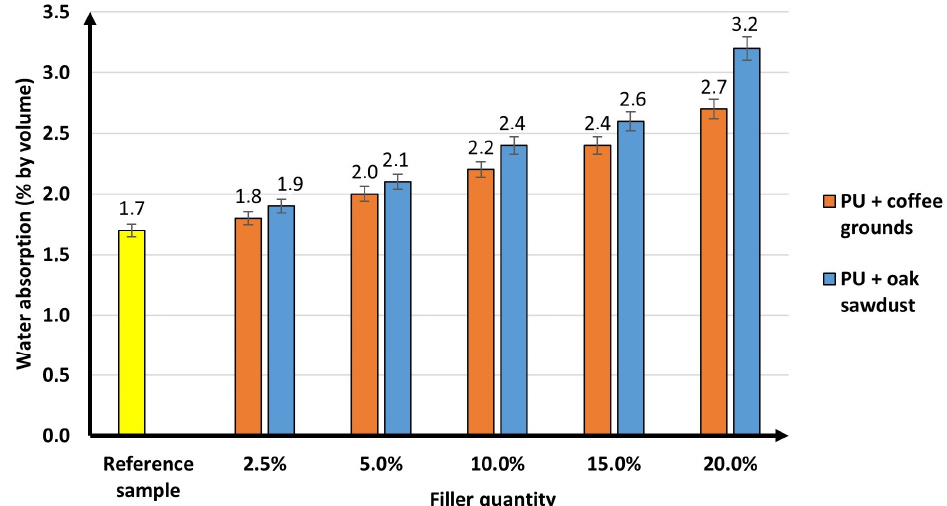
Figure 8. Water absorption by complete immersion for 24 h of the reference sample and polyurethane composites.